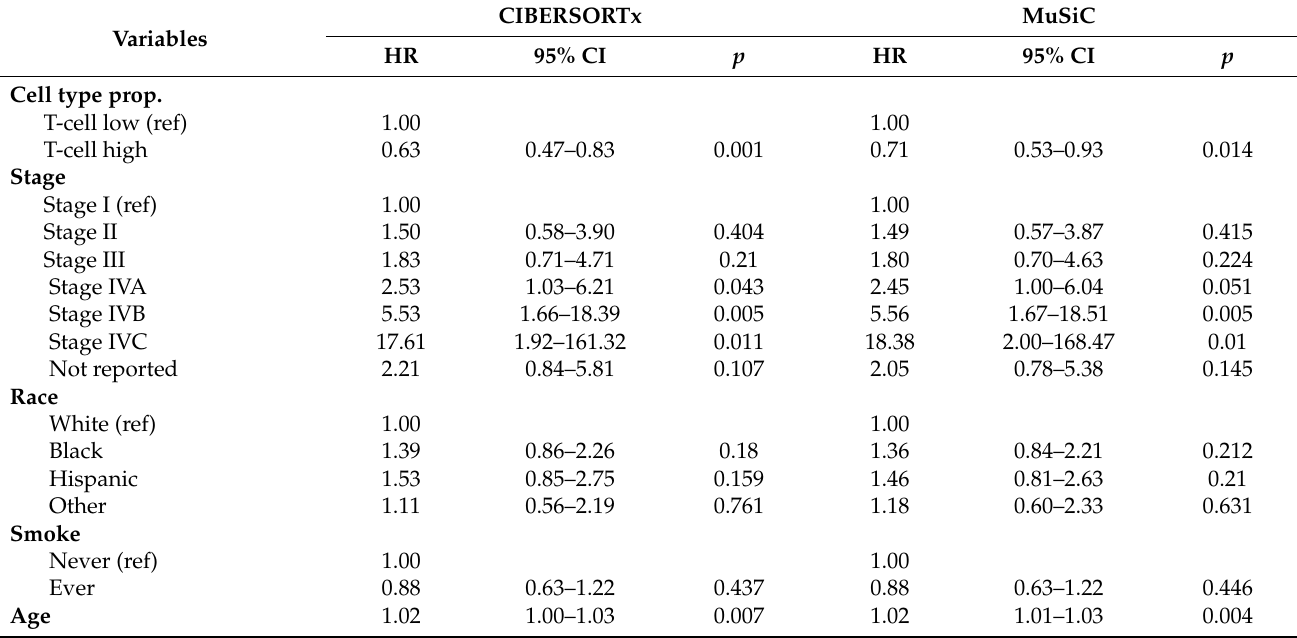
Table 1. Cox proportional-hazard regression analysis for survival and T-cell proportions estimated by CIBERSORTx and MuSiC (prop., proportion; HR, hazard ratio; CI, confidence interval; ref, reference). Variables